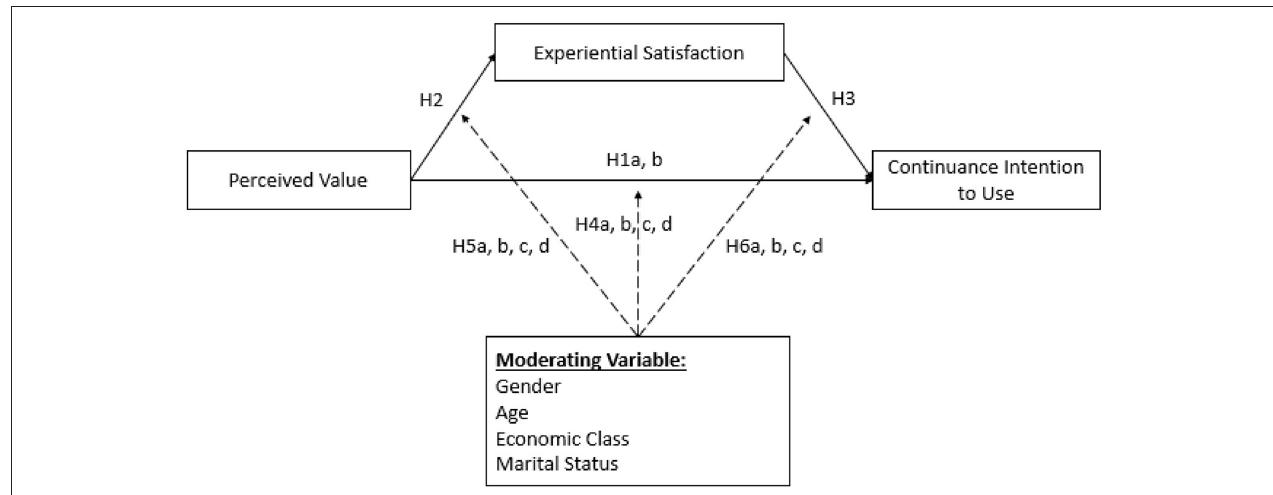
FIGURE 1 | Conceptual model. 4a, The effect of gender as moderating variable on the effect of perceived value to continuance intention to use. 4b, The effect of age as moderating variable on the effect of perceived value to continuance intention to use. 4c, The effect of economic class as moderating variable on the effect of perceived value to continuance intention to use. 4d, The effect of marital status as moderating variable on the effect of perceived value to continuance intention to use. 5a, The effect of gender as moderating variable on the effect of perceived value to experiential satisfaction. 5b, The effect of age as moderating variable on the effect of perceived value to experiential satisfaction. 5c, The effect of economic class as moderating variable on the effect of perceived value to experiential satisfaction. 5d, The effect of marital status as moderating variable on the effect of perceived value to experiential satisfaction. 6a, The effect of gender as moderating variable on the effect of experiential satisfaction to continuance intention to use. 6b, The effect of age as moderating variable on the effect of experiential satisfaction to continuance intention to use. 6c, The effect of economic class as moderating variable on the effect of experiential satisfaction to continuance intention to use. 6d, The effect of marital status as moderating variable on the effect of experiential satisfaction to continuance intention to